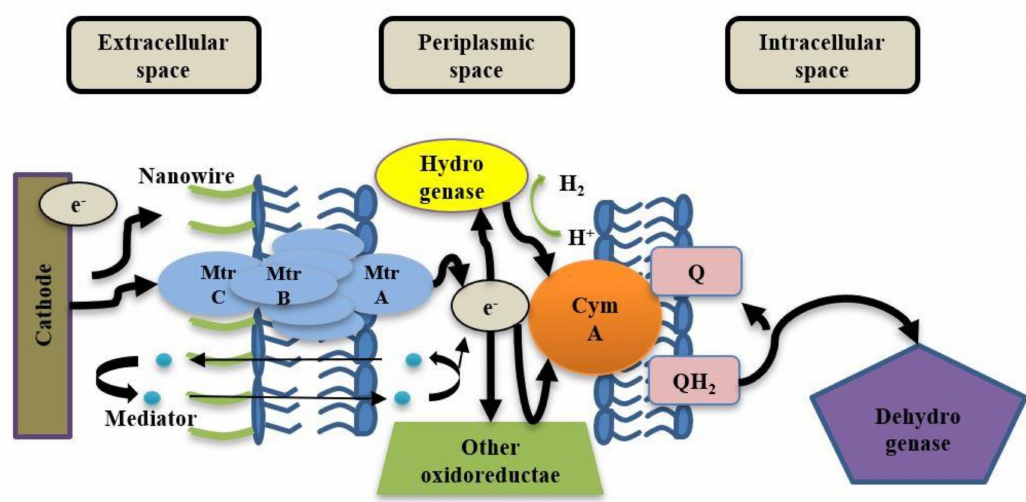
Figure 6. A diagram representing di ff erent extracellular electron transfer (EET) mechanisms in Shewanella spp., wherein electrons extracted at the inner membrane are transferred by the c-type cytochrome CymA to the outer membrane and can be transported to an electron acceptor by metal-reduction (MTR) proteins to complete EET and reduction reactions facilitated by the mediators at the